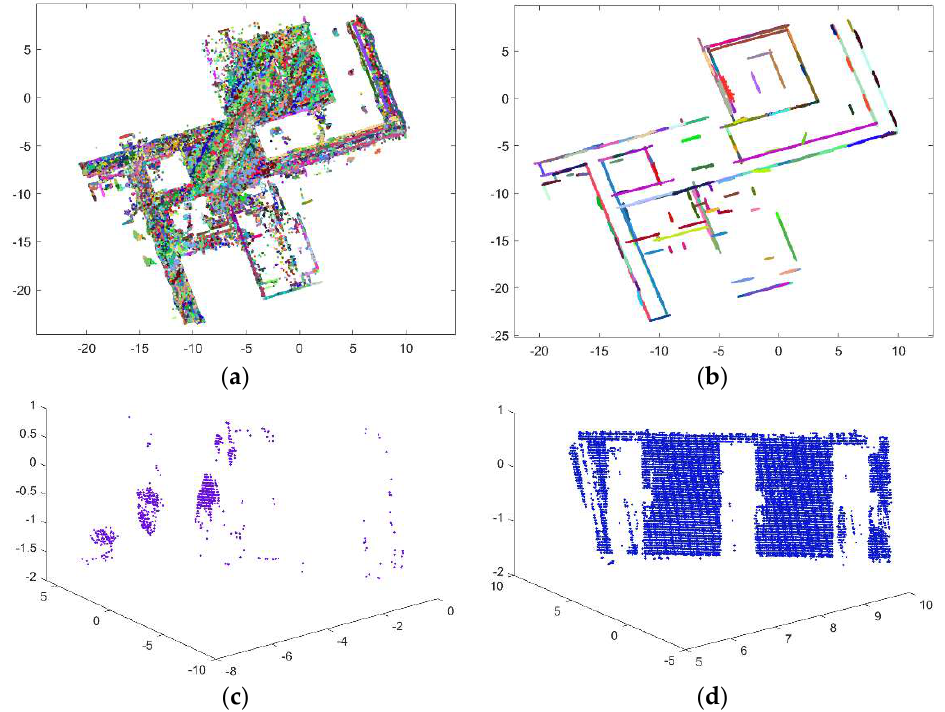
Figure 3. Wall segments analysis: ( a ) Raw wall segments; ( b ) pruned wall segments; ( c ) side view of the false wall; and ( d ) side view of actual wall segments.